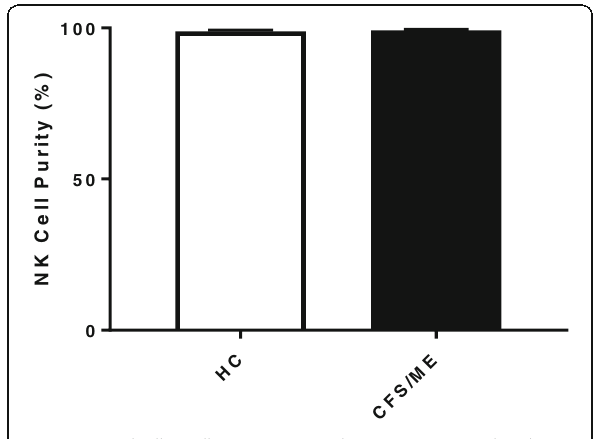
Fig. 1 Natural Killer cell purity . Bar graphs representing isolated NK cell purity for HC and CFS/ME patients. Data presented as mean